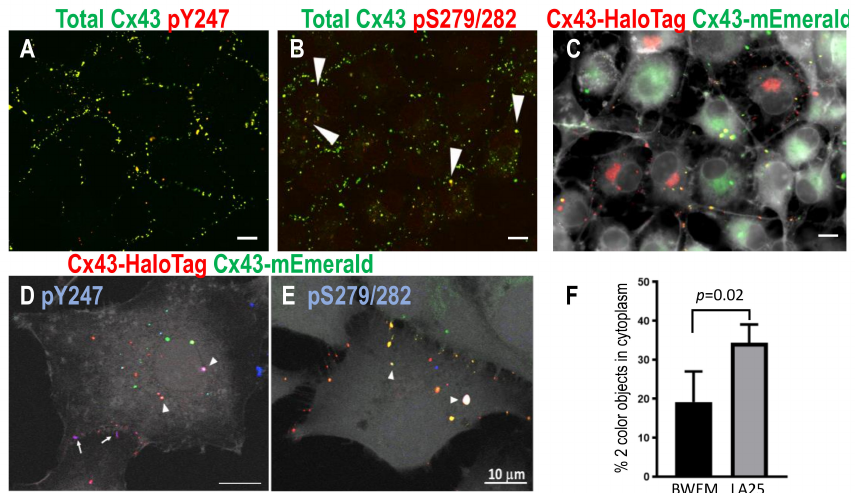
Figure4. LA25cellsstainedfortotalCx43andpY247( A )andpS279 / 282( B ,arrowspointtoyellow,